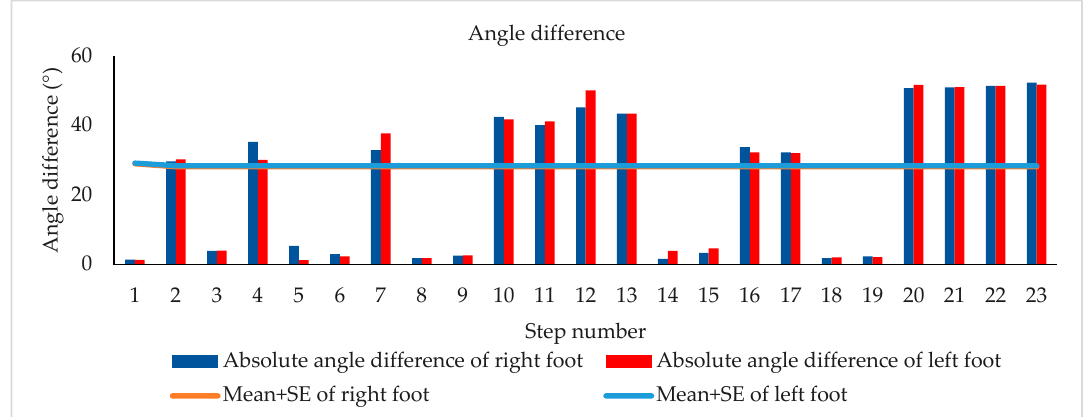
Figure 4 . Angle difference of one subject during walking.